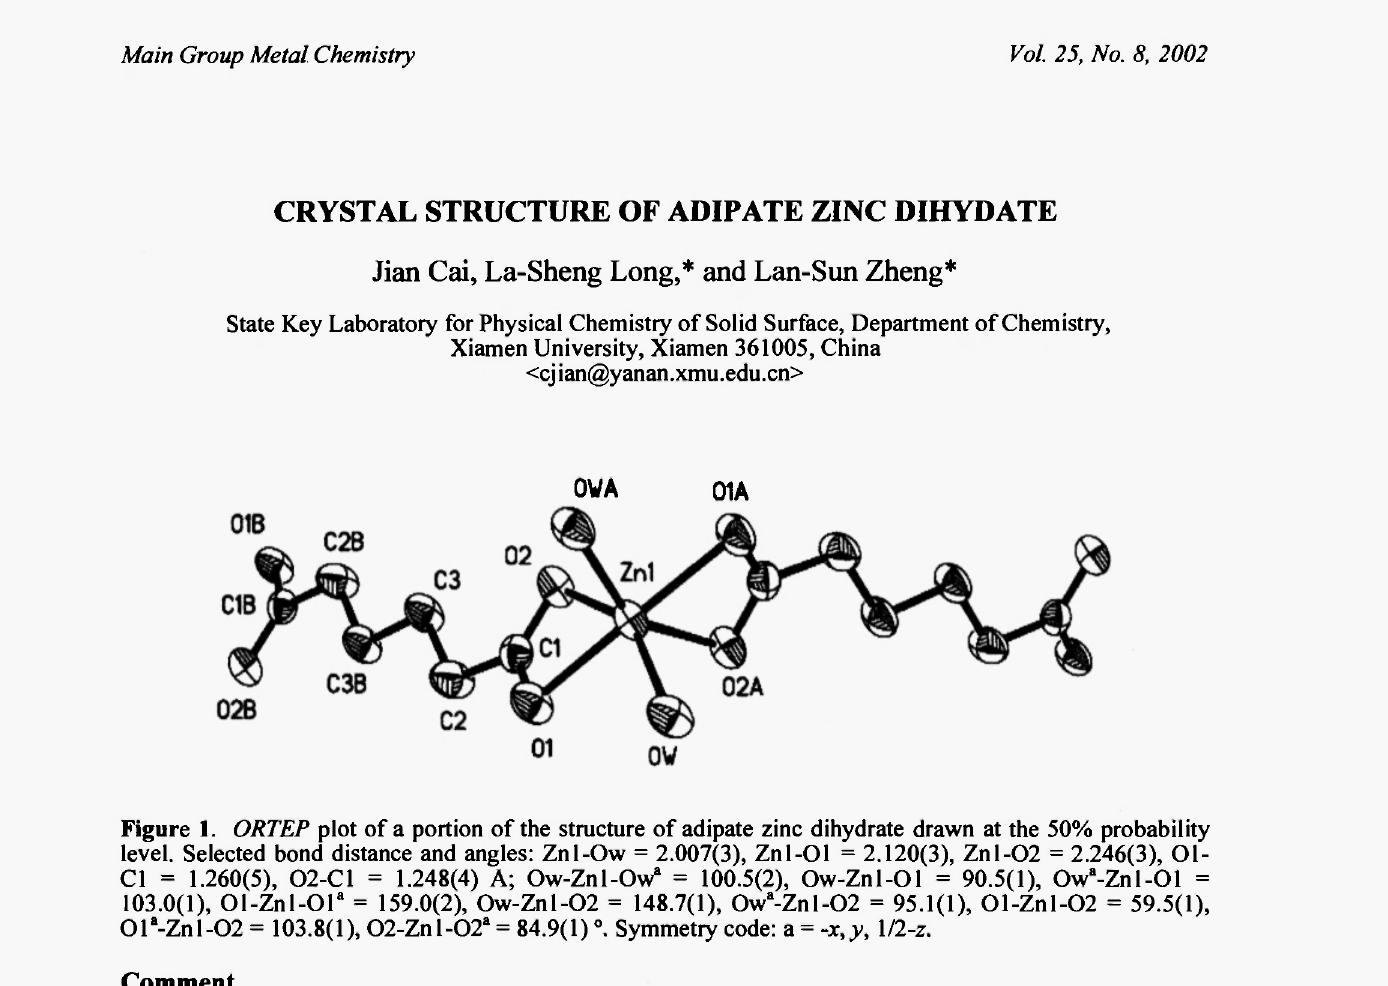
Figure 1. ORTEP plot of a portion of the structure of adipate zinc dihydrate drawn at the 50% probability level. Selected bond distance and angles: Znl-Ow = 2.007(3), Znl-Ol = 2.120(3), Znl-02 = 2.246(3), Ol- C1 = 1.260(5), 02-C1 = 1.248(4) A; Ow-Znl-Ow a = 100.5(2), Ow-Znl-Ol = 90.5(1), 0w a -Znl-01 = 103.0(1), Ol-Znl-Ol" = 159.0(2), 0w-Znl-02 = 148.7(1), 0w a -Znl-02 = 95.1(1), 01-Znl-02 = 59.5(1), 01 a -Znl-02 = 103.8(1), 02-Znl-02 a = 84.9(1) Symmetry code: a = -x,y, 1/2-z.